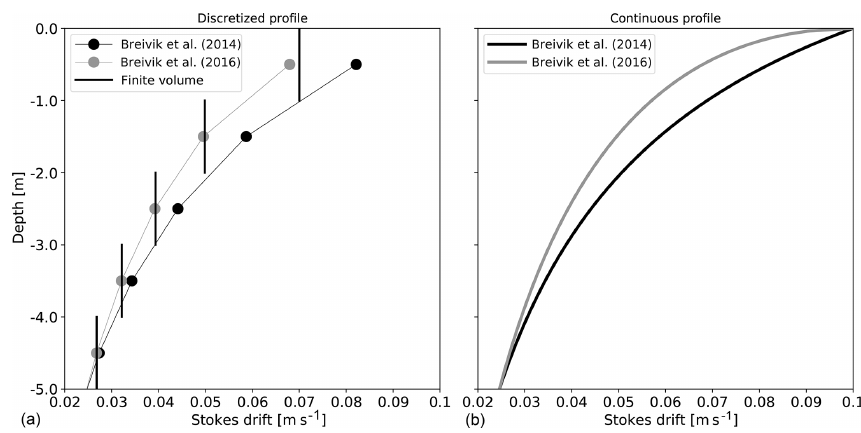
Figure 1. (a) Reconstructed zonal component of a Stokes drift profile for (cid:107) T s (cid:107) = 0 . 4m 2 s − 1 , u s (z = η) = 0 . 1ms − 1 , and v s (z = η) = 0ms − 1 for a 1m resolution vertical grid using the Breivik et al. (2014) function (black dots), the Breivik et al. (2016) function (grey dots), and the finite-volume Breivik et al. (2016) function (black vertical lines). (b) Their continuous